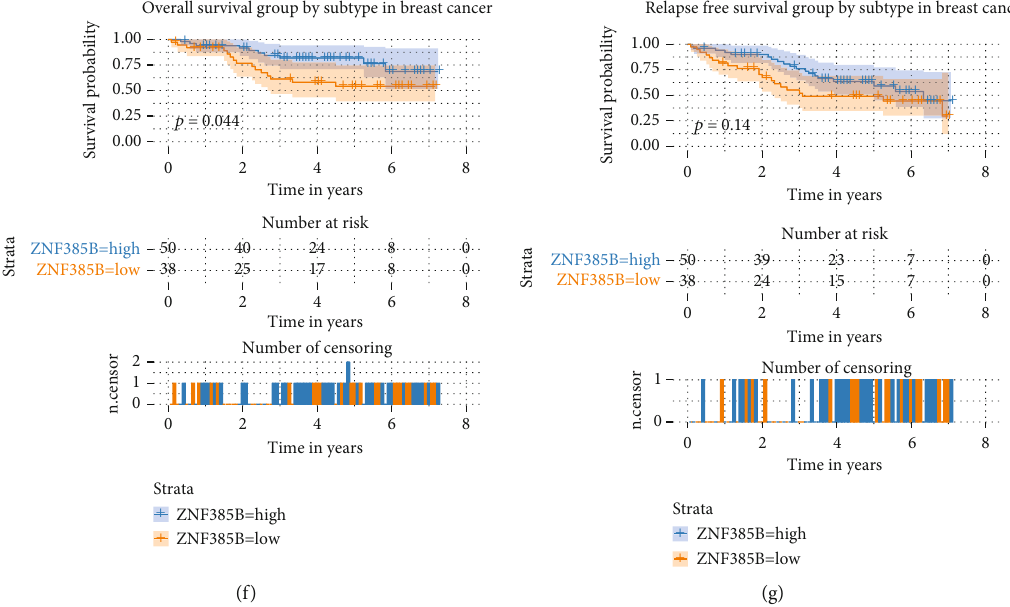
Figure 5: Association between mRNA expression levels of ZNF385B and pathological parameters of breast cancer. The parameters included ER, HER-2, grade, and subtype. Low ZNF385B expression related with short OS. The validation data from GEO database were analyzed. p < 0 : 05 was considered as statistically signi fi cant.